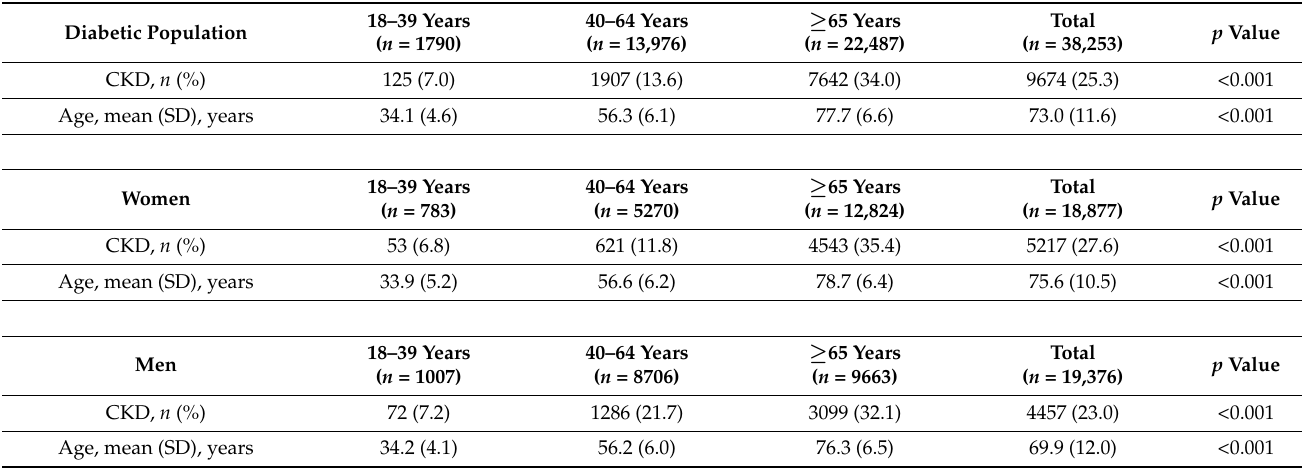
Table 1. Distribution of the diabetic population with CKD diagnosed by a sustained eGFR <60 mL/min/1.73 m 2 and a sustained UACR ≥ 30 mg/g.